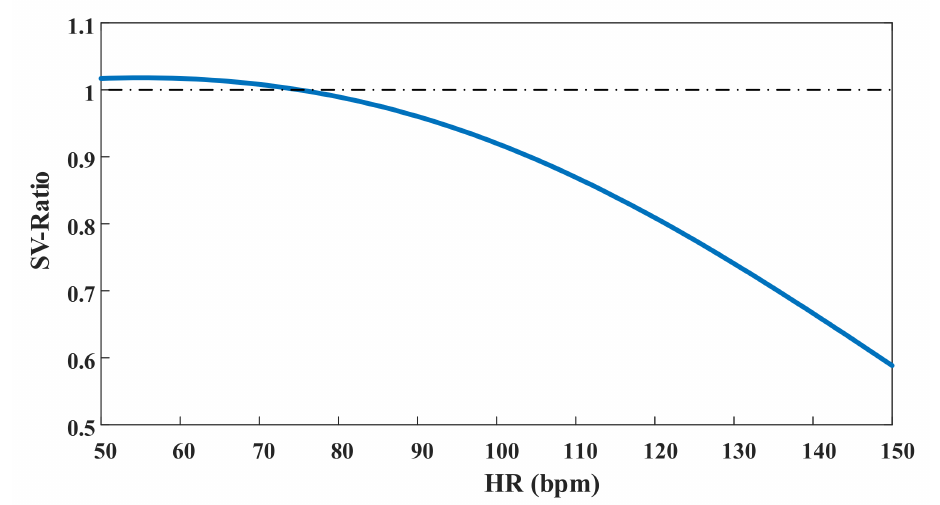
Figure 3. Relative value of SV under different heart